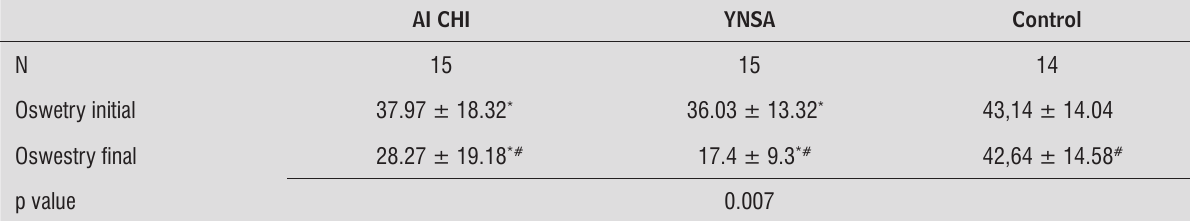
Table 3 - Mean and standard deviation of Oswestry Disability Index for groups AI CHI, YNSA and CONTROL at evaluation and revaluation periods; p value of variance analysis for repeated